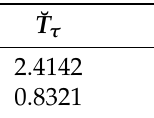
Figure 2. Instantaneous error states for the I part between for the variable ˘ x of (18) and ˘ y of (19) under 30 random initial values for asymptotical synchronization. Table 1. The related values under two